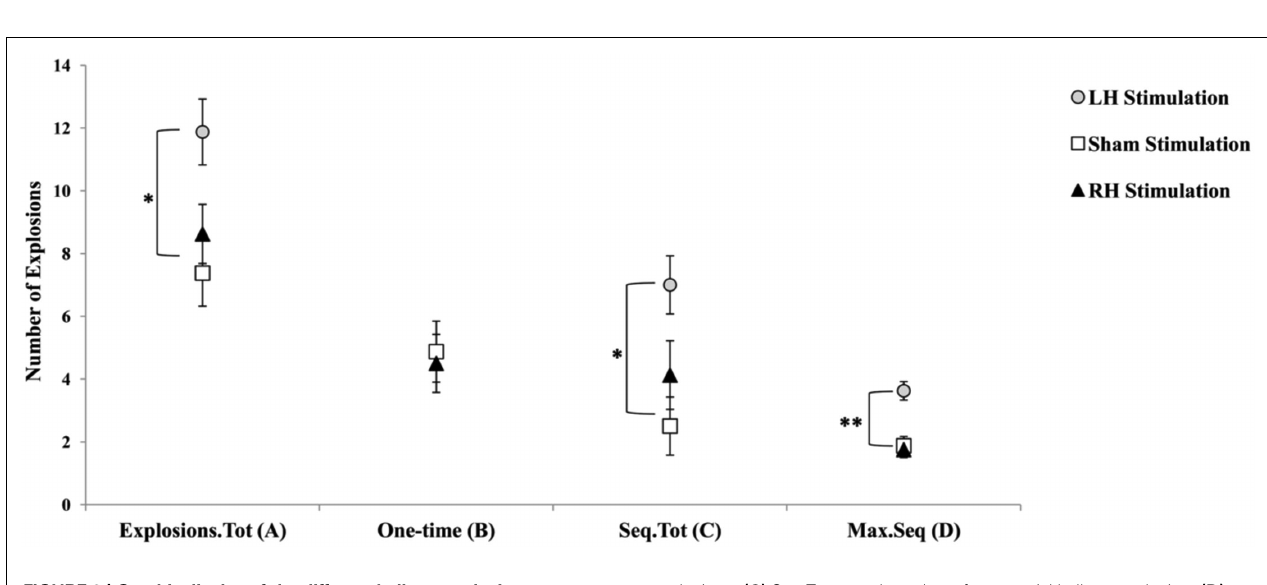
FIGURE 3 | Graphic display of the different balloon explosions frequencies dependent measures. (A) Explosions.Tot = total number of balloon explosions; (B) One-time = total number of one-time balloon